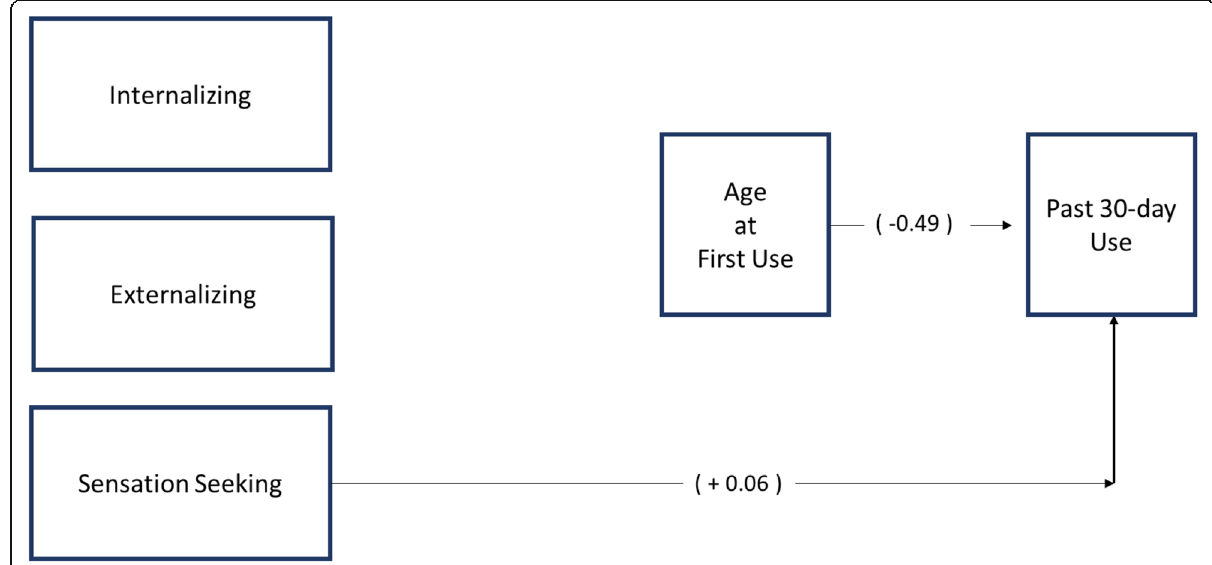
Fig. 2 No indirect effects were significant ( p > 0.05). Estimates are in parentheses. Relationships between youth factors and past 30-day tobacco and cannabis use mediated by age at first use of tobacco or